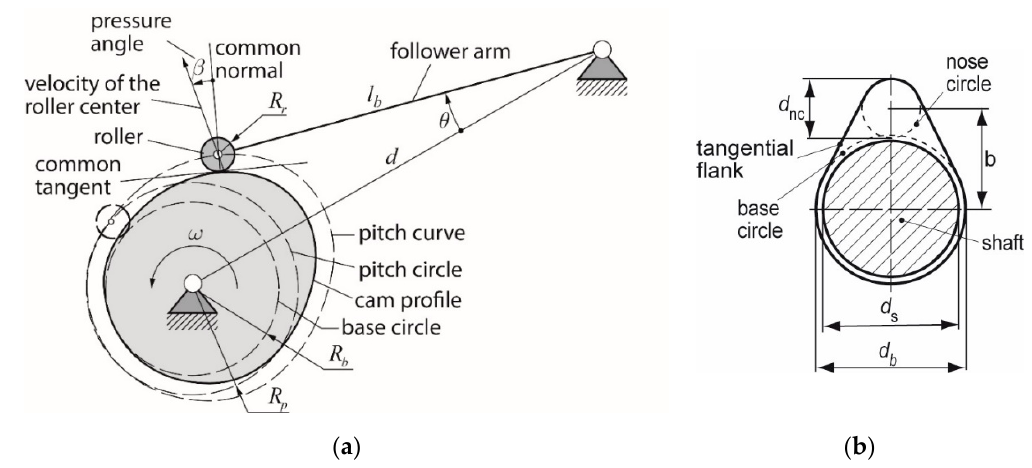
Figure 1. ( a ) Parts of a disk cam mechanism with an oscillating roller follower; ( b ) typical tangential flank cam from a combustion engine.